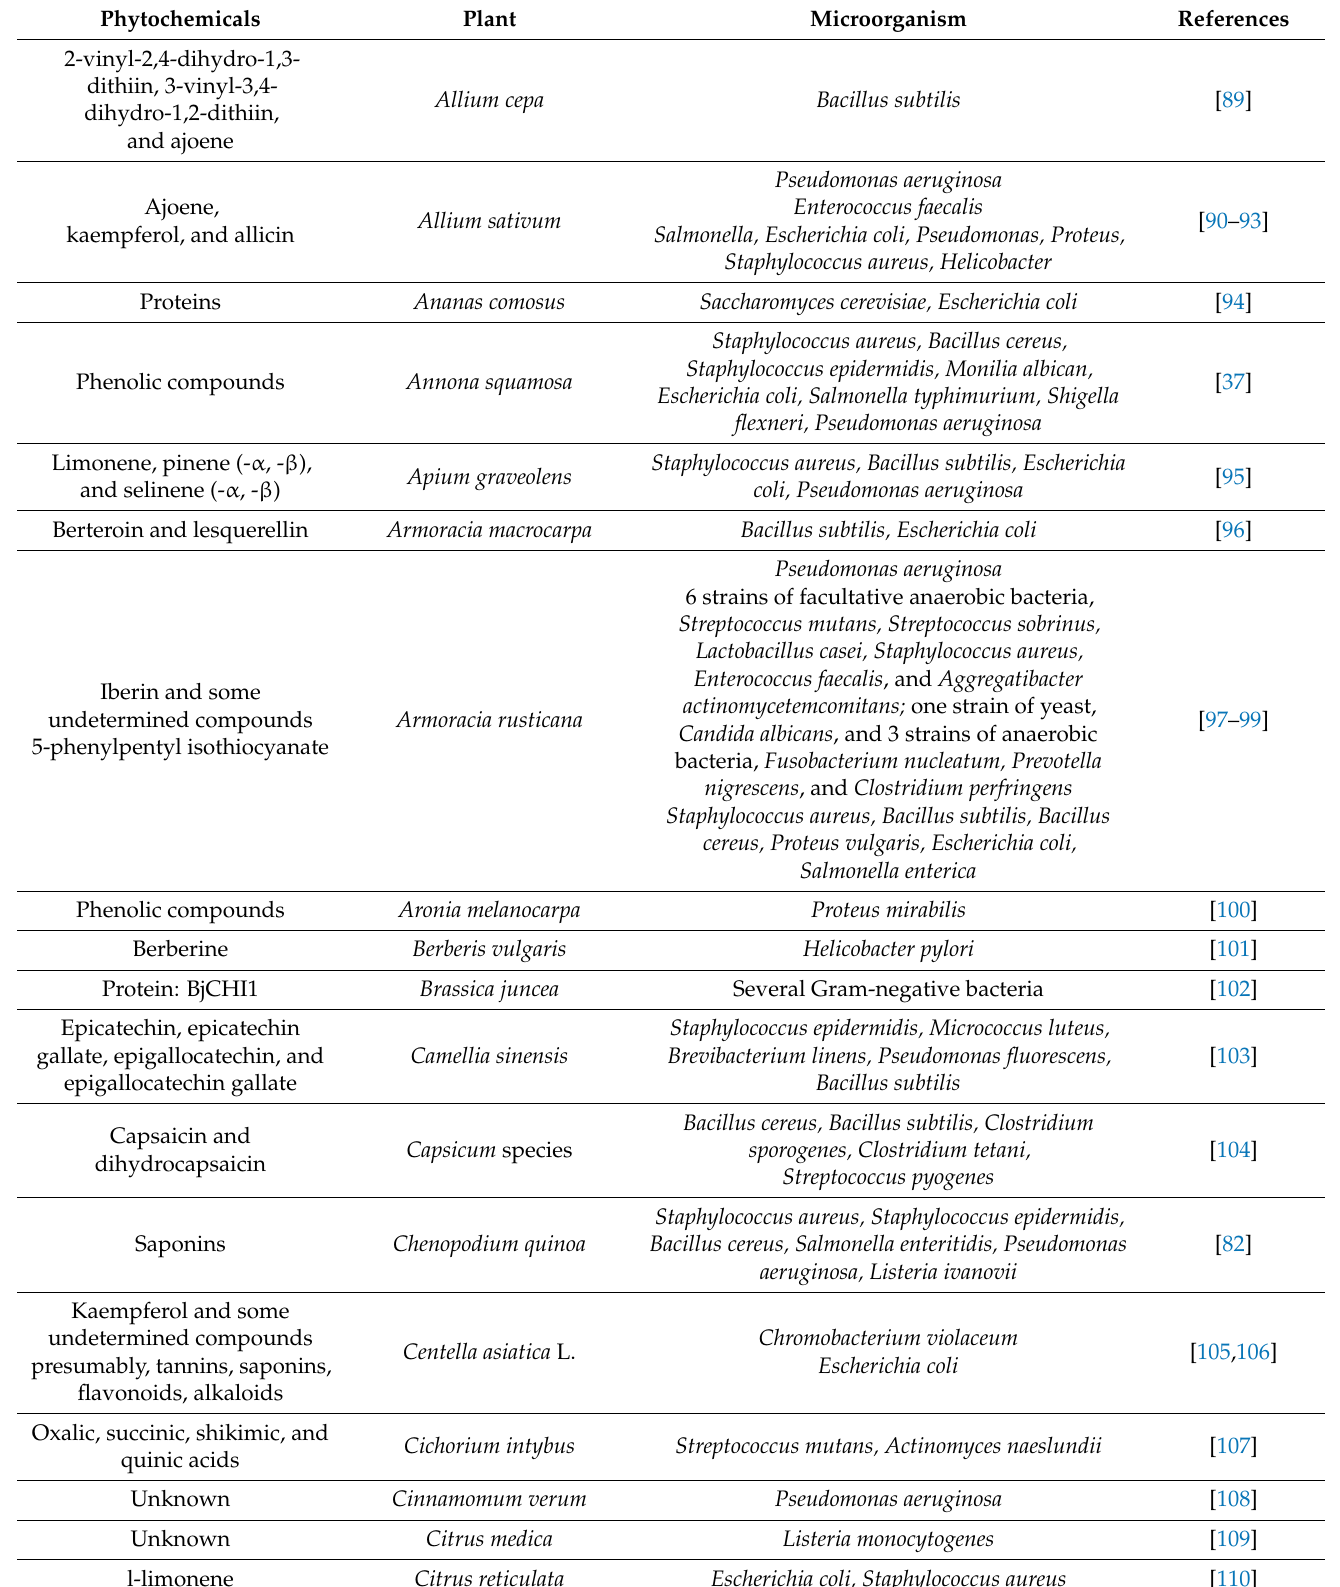
Table 1. Edible plants with antimicrobial